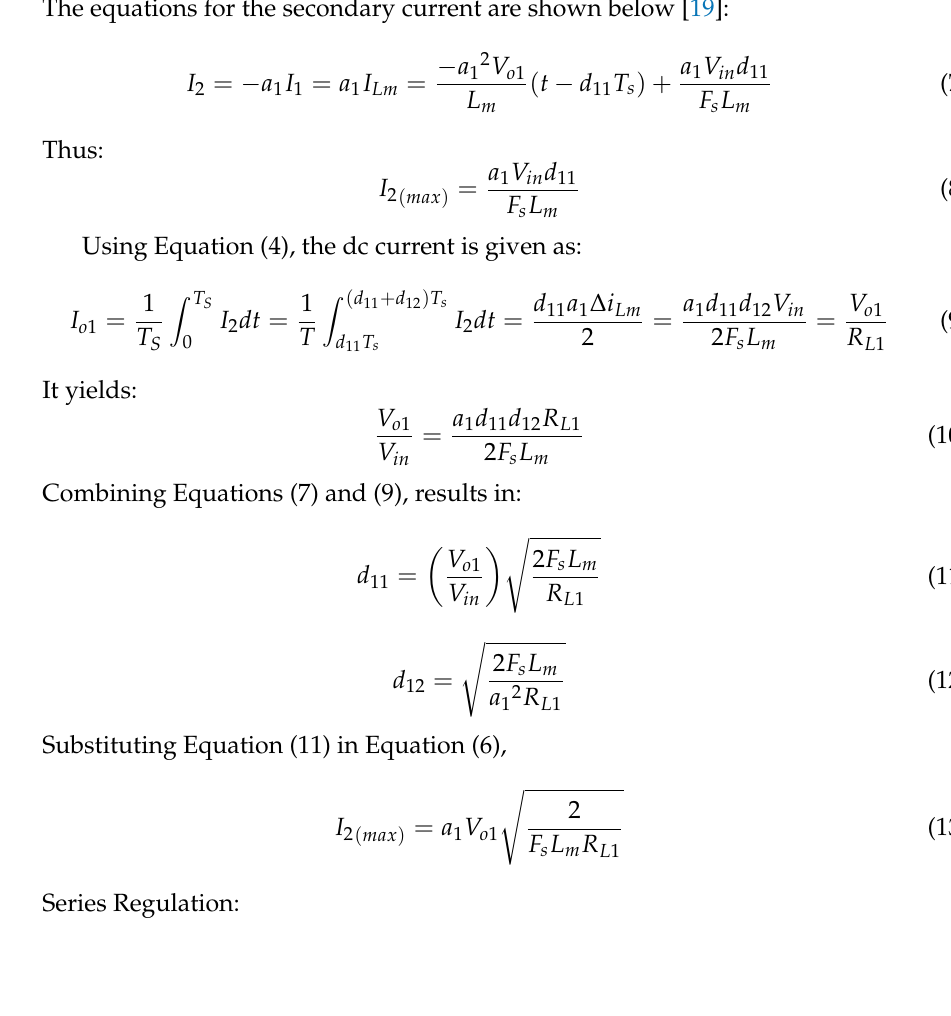
Figure 7. Equivalent circuits of the proposed SIMO power supply within T1–t12 and t14. Main